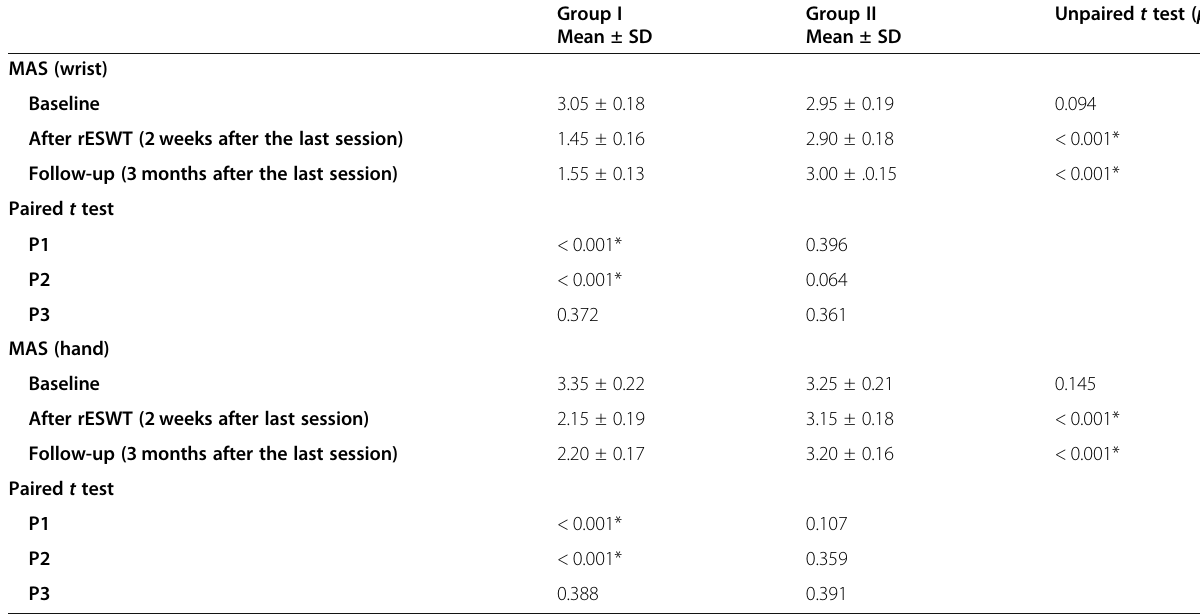
Table 2 Modified Ashworth Scale (MAS) for the wrist and hand in the studied groups at baseline, after rESWT, and at follow-up showing significant improvement in GI after receiving rESWT therapy relative to baseline and also a significant improvement in comparison to